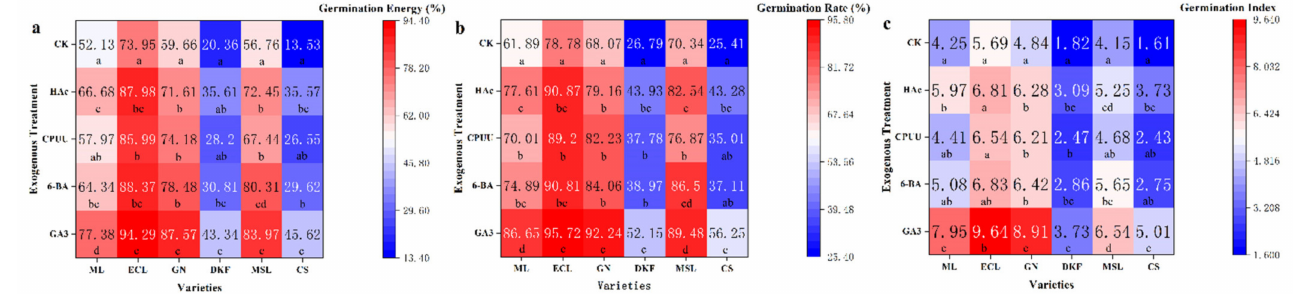
Figure 2. Effect of chemical treatments on seed germination characteristics of six tested varieties: ( a ) influence of chemical treatments on seed germination rate of tested varieties, ( b ) influence of chemical treatments on seed germination potential of tested varieties, and ( c ) influence of chemical treatments on seed germination index of tested varieties. Data in this figure were tested by One- way ANOVA; means followed by the same letter in a column do not differ according to Tuker’s test ( p ≤ 0.05). ML, ECL, GN, DKF, MSL, and CS represent varieties of Meili, Ecolly, Garanior, Dunkelfelder, Marselan, and Cabernet